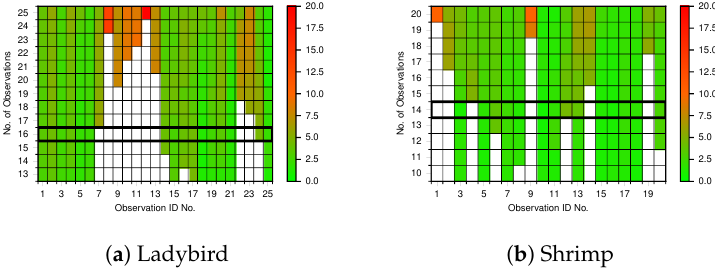
Figure 8. Outlier removal and average reprojection errors for ( a ) Ladybird and ( b ) Shrimp. Each row represents an iteration as described in Section 3.5, labelled with the number of remaining observations, and each column represents an observation of the calibration pattern as per Figure 5. White cells indicate that an observation has been removed for that iteration. Otherwise, the cell colour indicates the mean reprojection error in pixels for that particular observation of the calibration pattern at a given outlier removal iteration. For example, in ( a ), observation No. 12 exhibited the greatest mean reprojection error with 25 observations, and was therefore the first observation to be removed. The highlighted rectangle points to the row with the greatest number of remaining observations with a mean reprojection error of less than 5